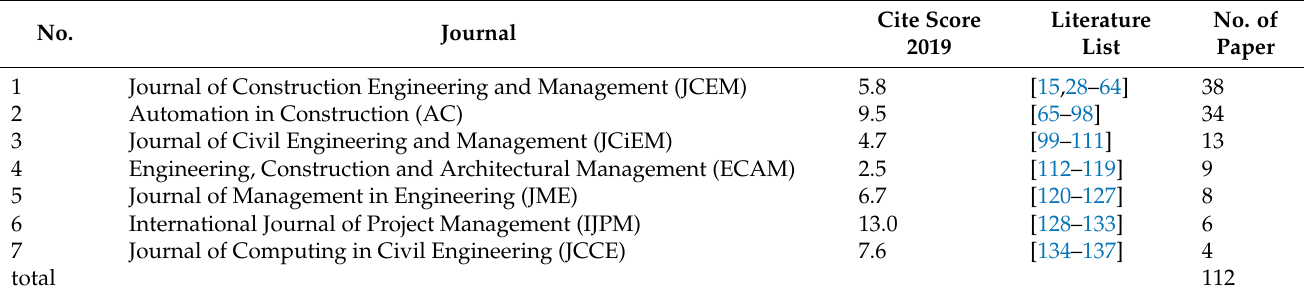
Table 1. Distribution of the selected papers among different